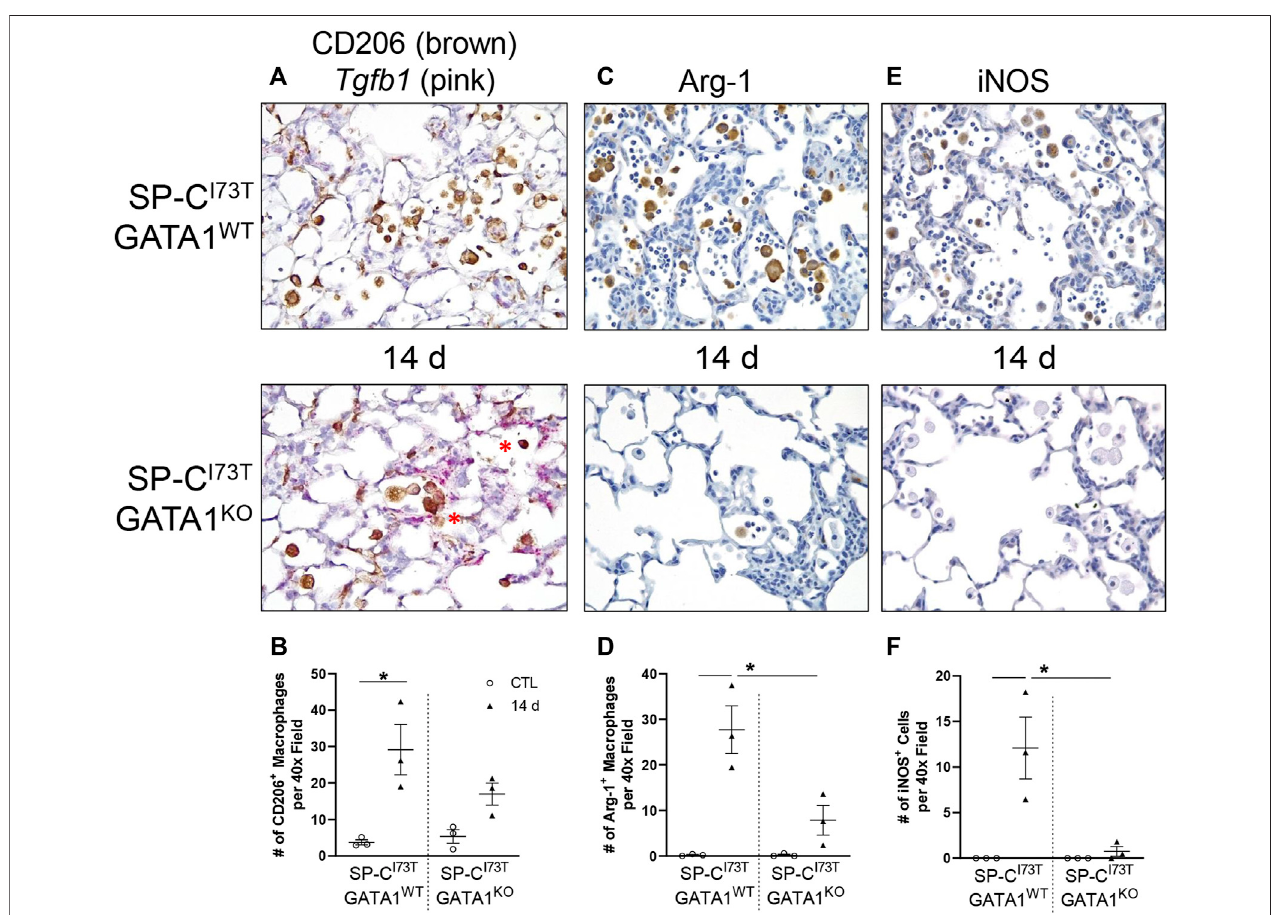
FIGURE 5 | Effects of genetic eosinophil lineage ablation on pro-in fl ammatory activation following SP-C I73T induced injury. Histochemical analysis alone or in combination with in situ hybridization of SP-C I73T GATA1 WT and SP-C I73T GATA1 KO lungs 14 days post SP-C I73T induced injury. Sections were immunostained with antibody to (A) CD206 + Tgfb1 ( in situ hybridization). mRNA visualization is shown in pink. Protein expression was visualized using a DAB Vectastain kit (brown). Arrowheads indicate cells expressing the receptor. (C) Arg-1 or (E) iNOS. Binding was visualized using a Vectastain kit. Original magni fi cation, ×400. Representative sections from three mice/group are shown. Quanti fi cation of each respective antibody is shown in (B,D,F) as the average number of brown/positive in fl ammatory cells in ×400 images of regions of injury. Data are presented as mean ± SD ( n = 3 mice/group), analyzed using two-way ANOVA. A p < 0.05 (*) was considered signi fi